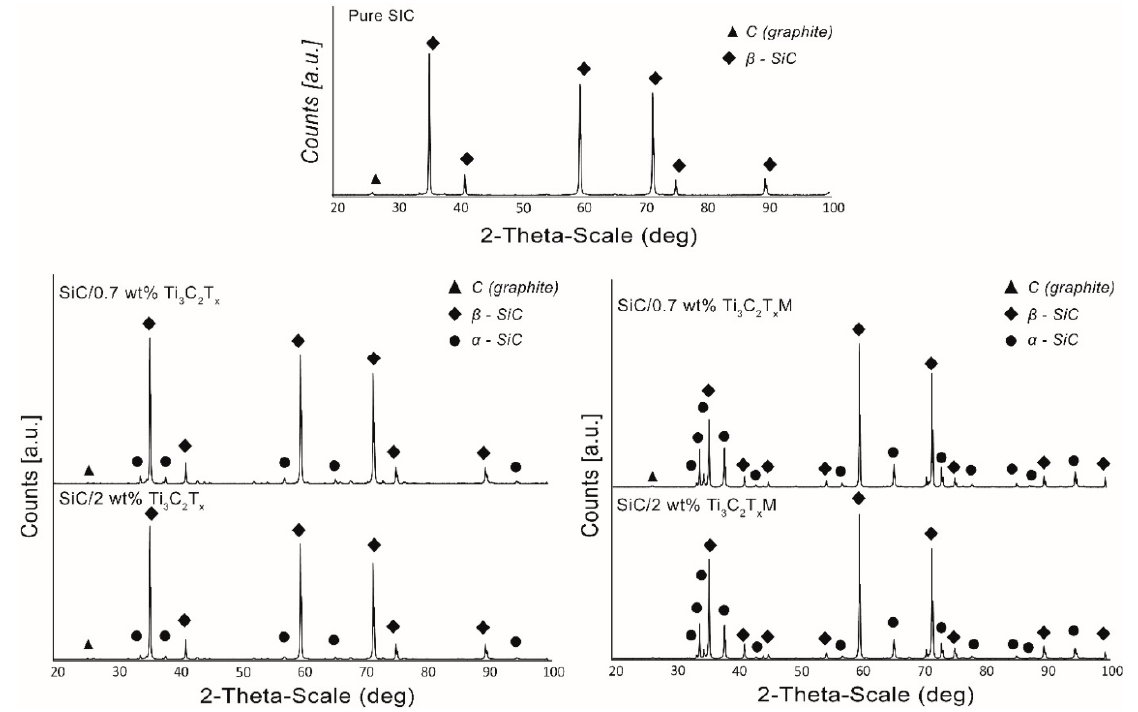
Figure 5. Phase composition of the obtained composites.